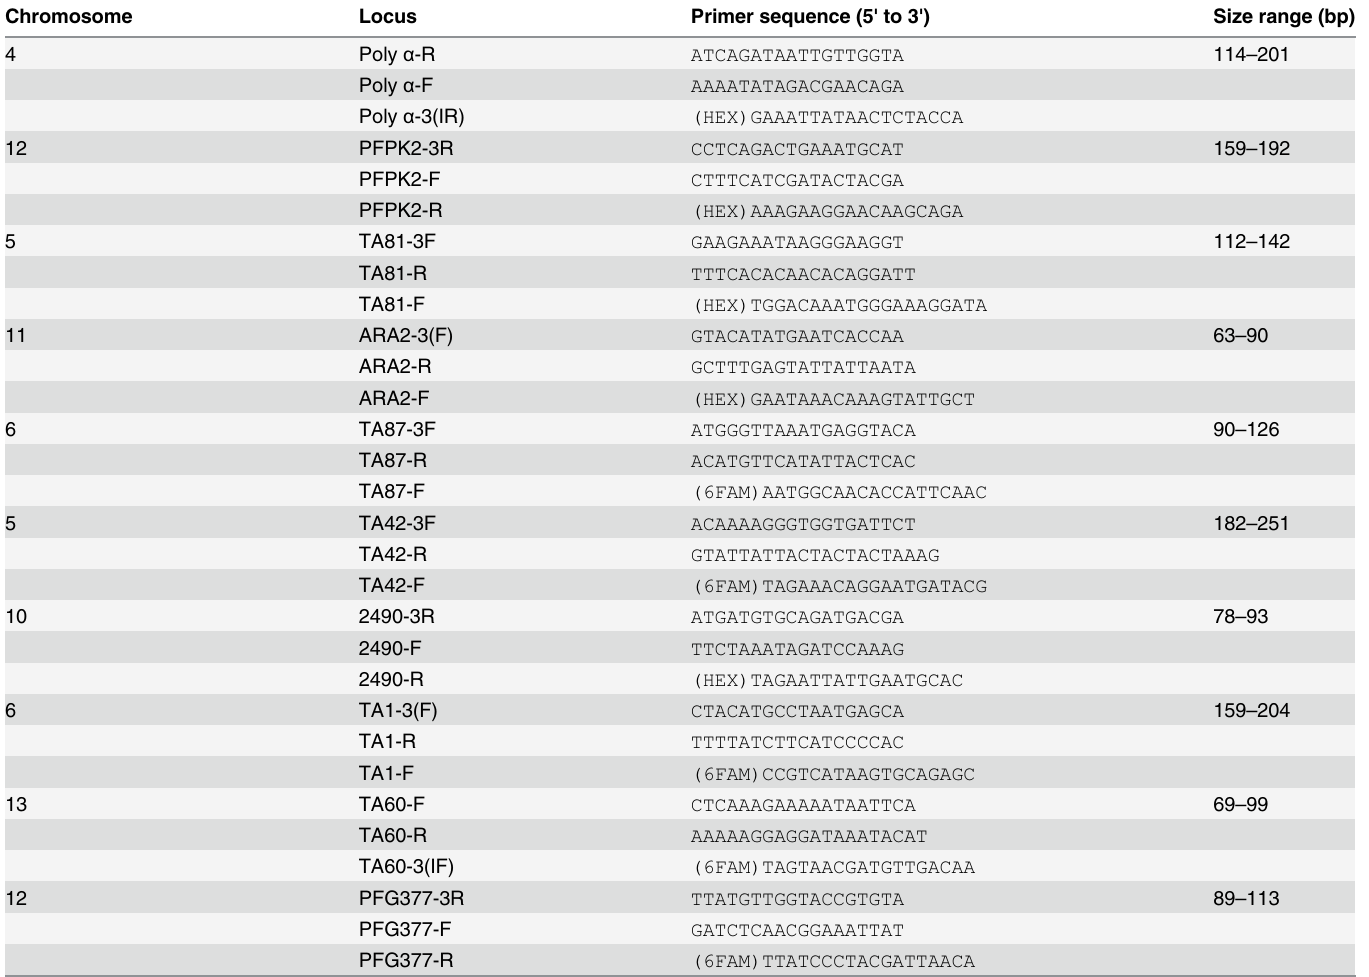
Table 2. The primers used to amplify the microsatellite markers of P . falciparum isolates from Kalabakan and Kota Marudu, Sabah. Chromosome Locus Primer sequence (5' to 3') Size range